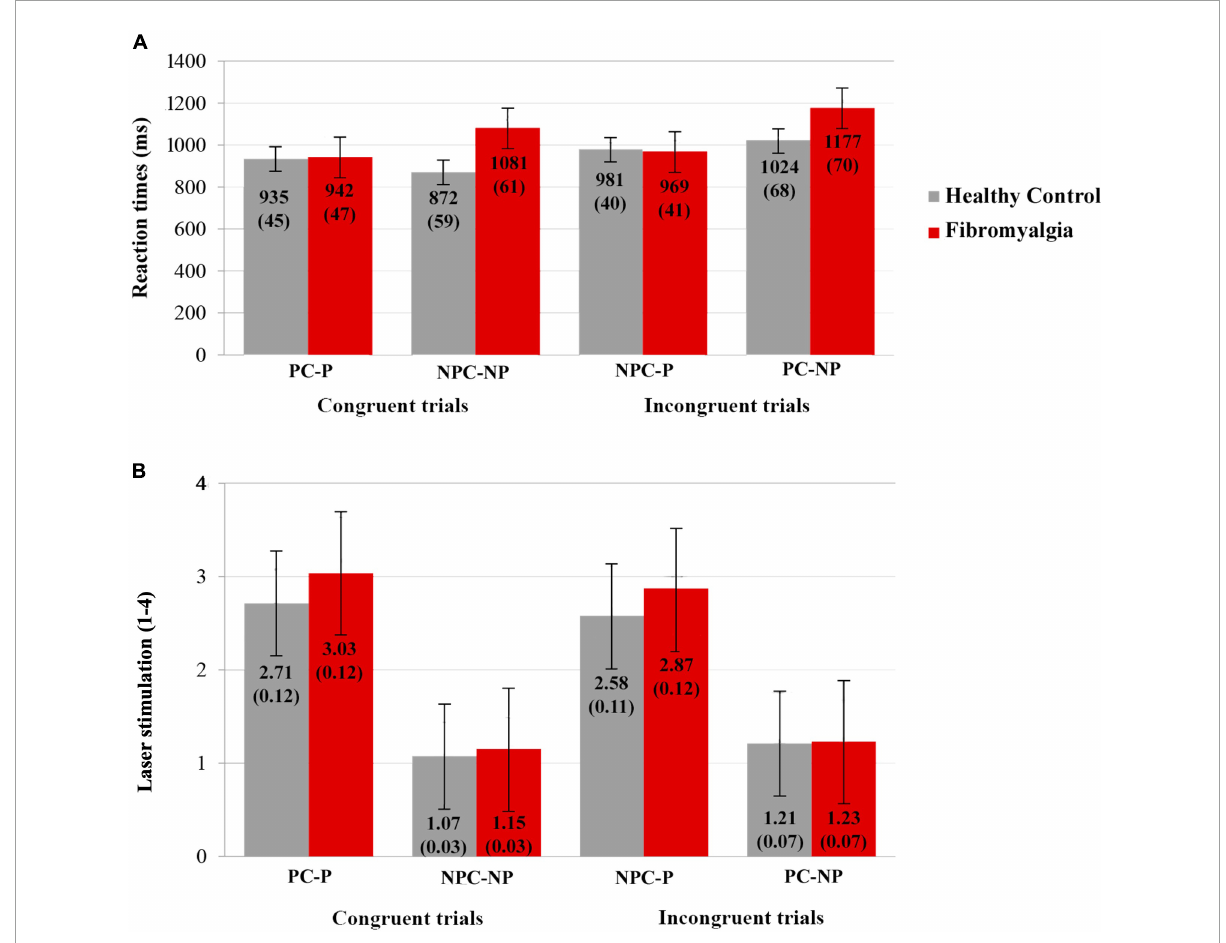
FIGURE6 Behavioral data: Mean and standard deviation of (A) RTs (ms) and (B) subjective perception of pain (1–4) for healthy control (gray) and fibromyalgia (red) of the four experimental conditions (PC-P, pain cue-pain; NPC-NP, no pain cue-no pain; NPC-P, no pain cue-pain; PC-NP, pain cue-no pain). Bars represent the standard